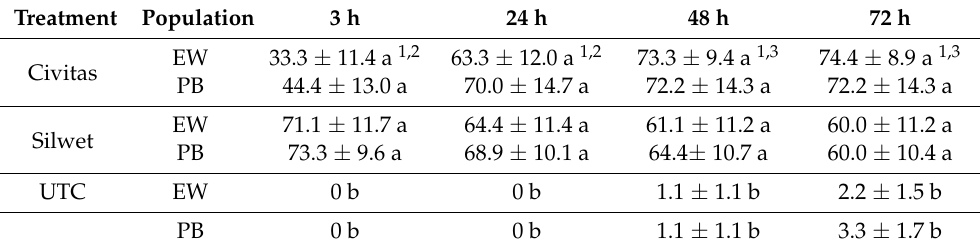
Table 1. Percent mortality of susceptible (PB) and resistant (EW) Listronotus maculicollis adults exposed to Civitas (9.6 L/ha) and Silwet (0.8 L/ha) (815 L/ha carrier volume, 100% filter paper satura- tion).